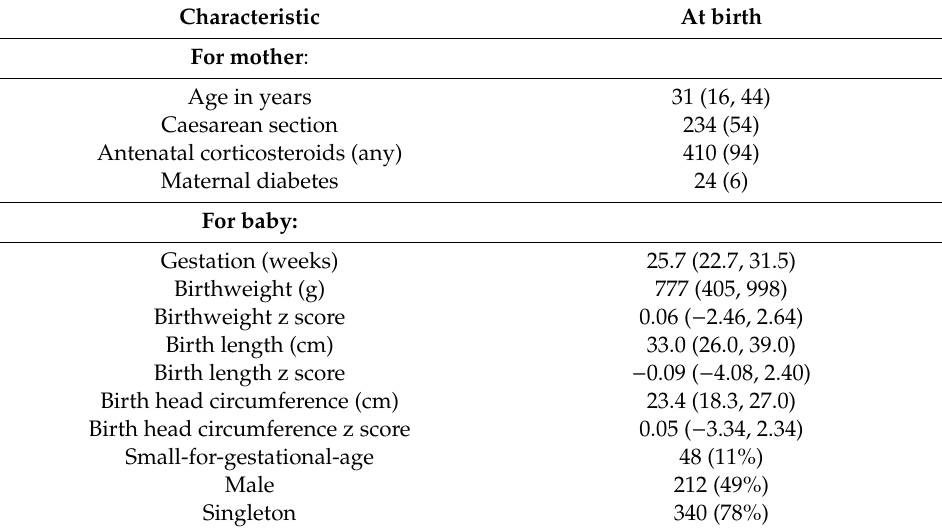
Table 2. Baseline demographic and clinical characteristics of the cohort.